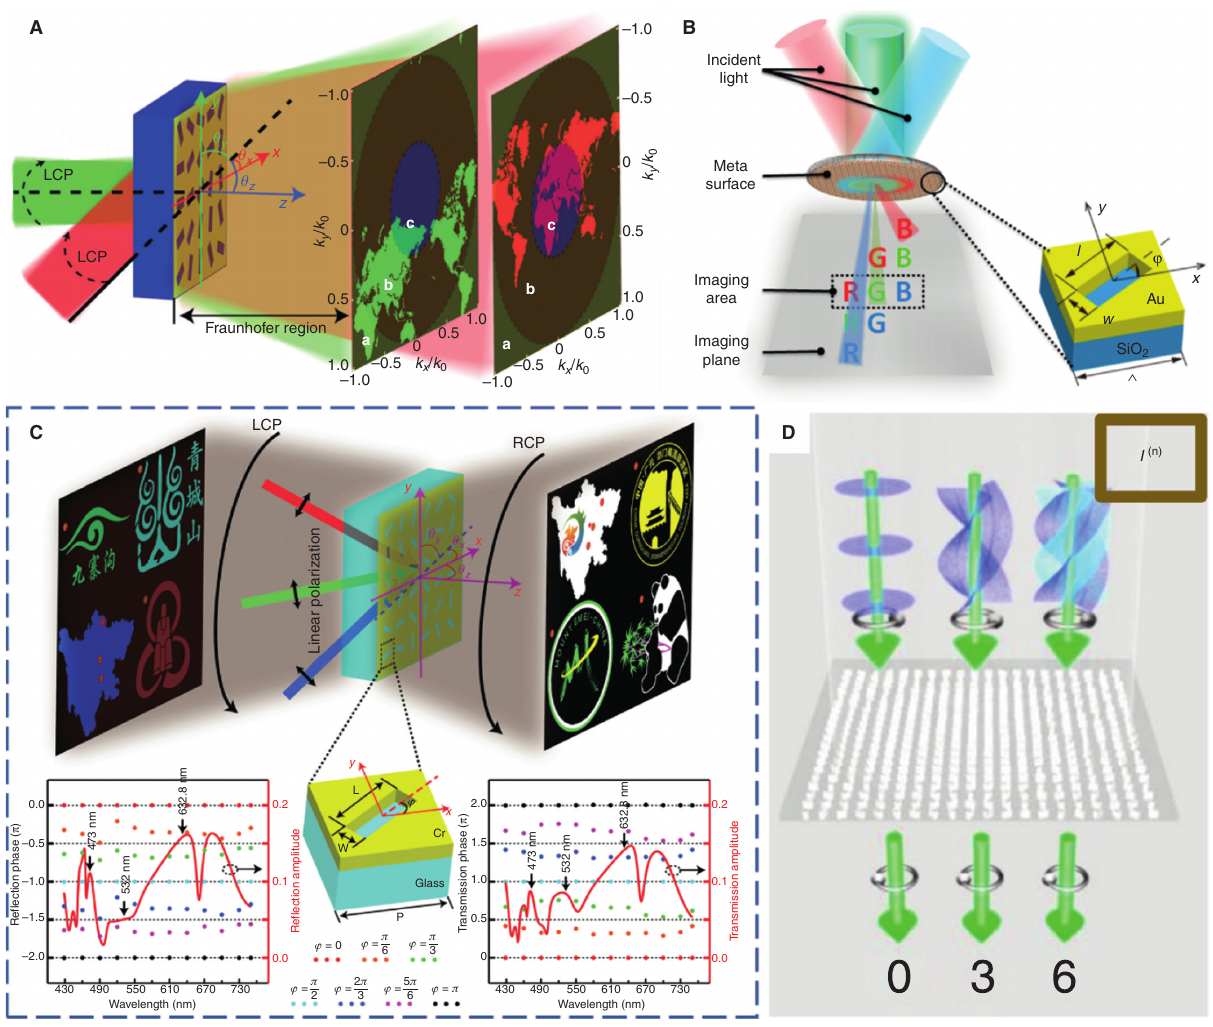
Figure 13: “Many-to-many” scheme for information multiplexing in terms of the incident end. (A) Multiplexed holograms with varied incident angles [100]. (B) Color holography using different incident angles for red, green, and blue light [101]. (C) Color holography in both transmission and reflection spaces using different incident angles for red, green, and blue light [102]. (D) Multiplexed metahologram using different topological charges [103]. Reprint permission obtained from